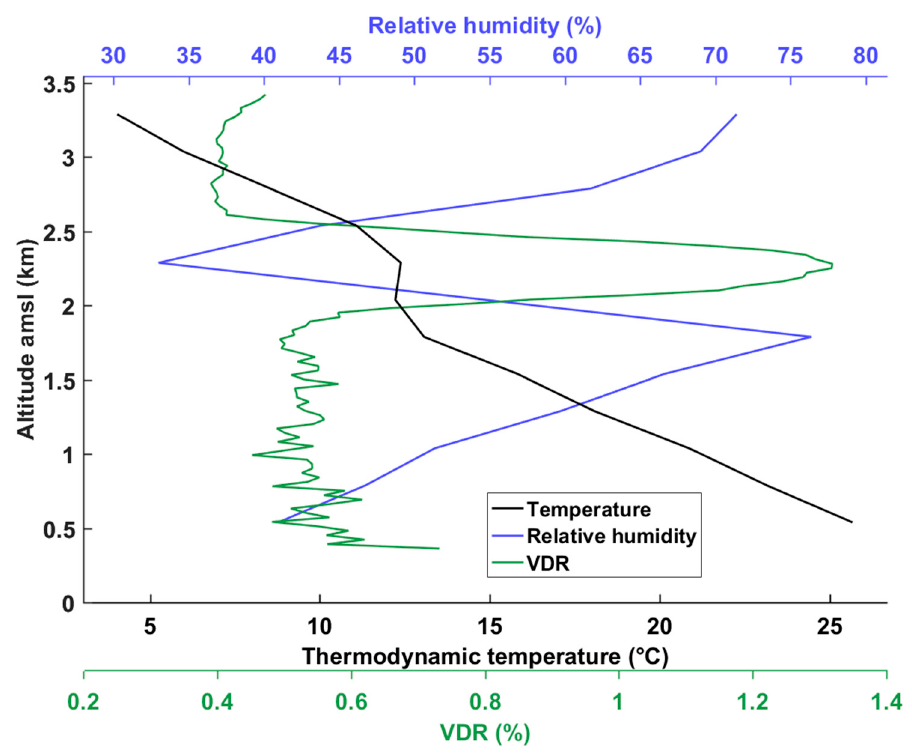
Figure 6. Vertical profiles of the relative humidity, temperature and volume depolarization ratio for the flight A on 18 June 2015.